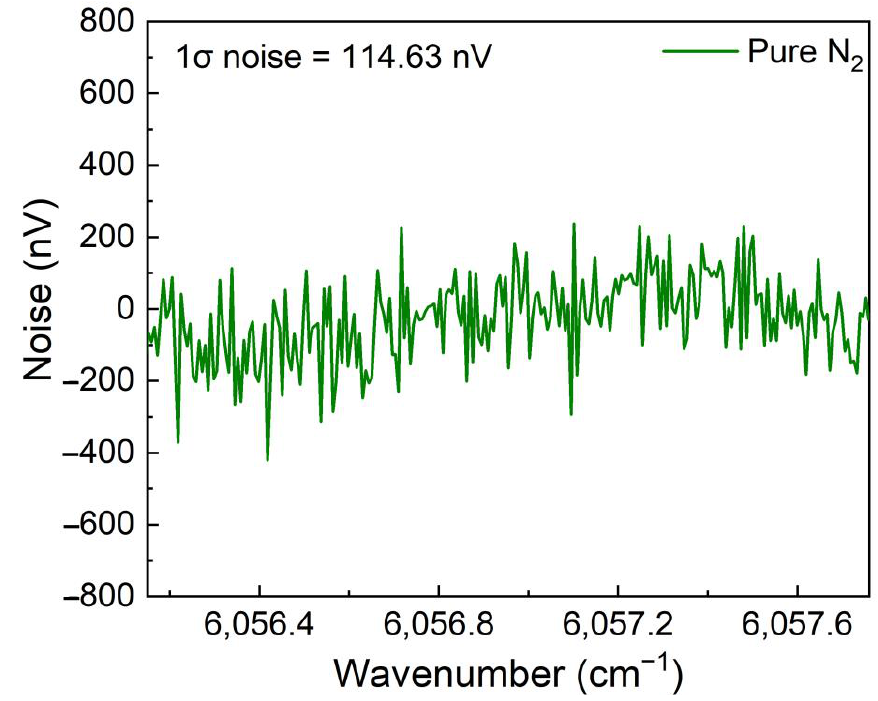
Figure 10. Noise level of CH 4 -QEPAS sensor with 3D-printed ADU.